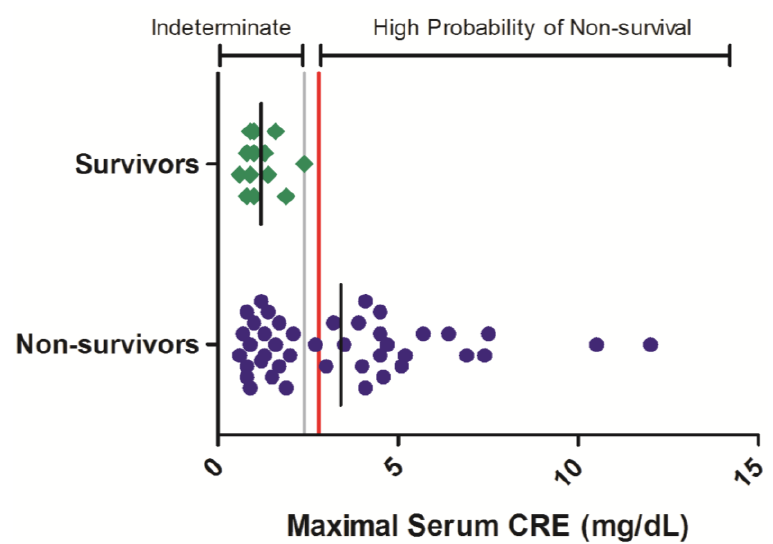
Figure 2. Serum CRE responses in rhesus monkeys exposed to Ebola virus. Symbols represent the maximal serum CRE value obtained at any time during the course of infection for an individual animal (diamonds = survivors, circles = non-survivors). Data were compiled from multiple independent historic experiments. The horizontal gray line indicates a survival threshold, i.e. , the maximal value obtained in any animal that survived infection. The red line indicates a proposed euthanasia threshold value based on ROC curve suggested values plus 10%. Black lines are the group mean. Normative serum CRE reference range for rhesus monkeys (mean +/− 1 SD) is 0.45–0.71 mg/dL